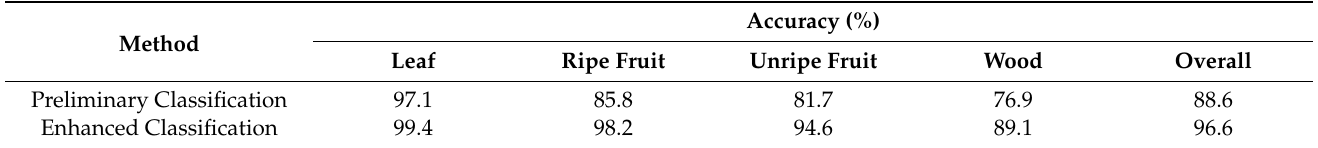
Table 4. Comparison of classification accuracy of the persimmon